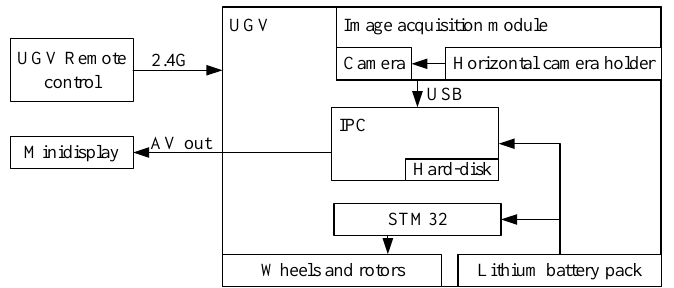
Figure 2. Structure diagram of the unmanned ground vehicle (UGV) system.